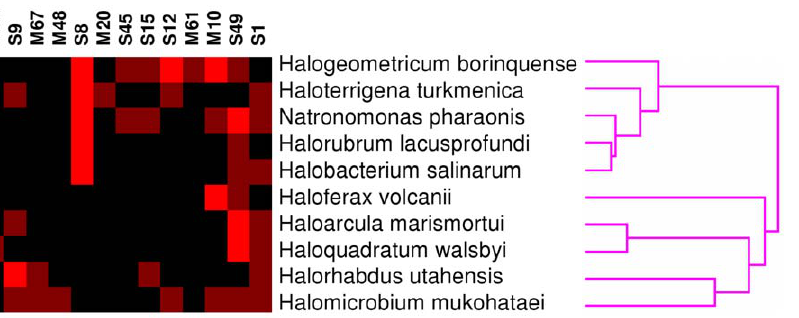
Figure 2. Secreted protease distribution in haloarchaeal genomes. A heat map shows the distribution of MEROPS protease families, and the tree shows the results of hierarchical